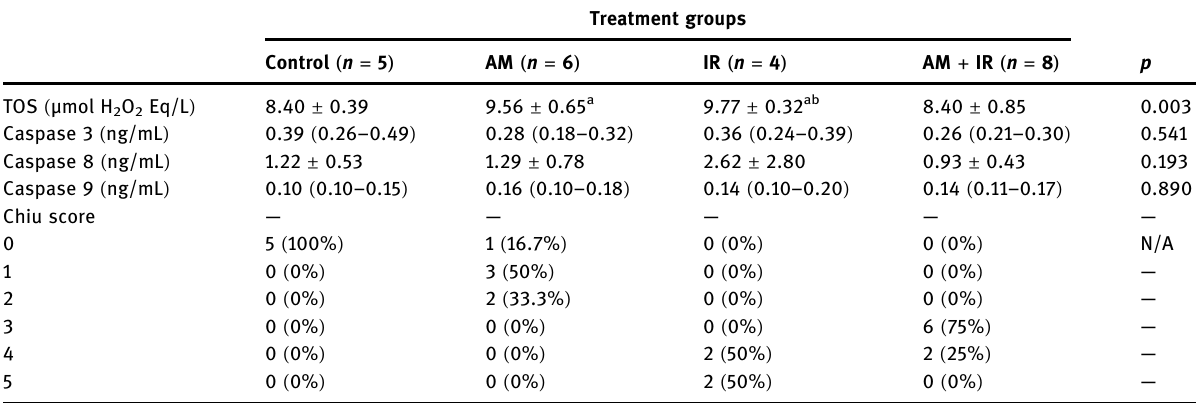
Data are given as mean value ± standard deviation or median ( 1st quartile – 3rd quartile ) for continuous variables according to normality of distribution, and as frequency ( percentage ) for categorical variables. a and b: signi fi cantly di ff erent from the control group and AM + IR treated group, respectively.